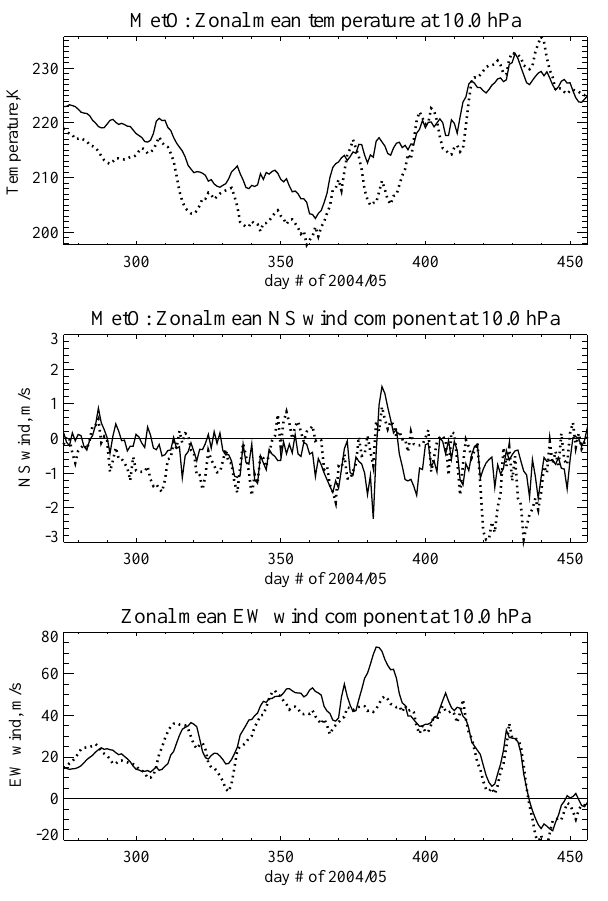
Fig. 1. Temperature (top), NS (middle) and EW (bottom) wind components from MetO 10hPa level averaged along the 60 ◦ N (solid) and 70 ◦ N (dashed) longitudinal circles for the time interval from 1 October 2004 till 31 March 2005 (day numbers 275–456).